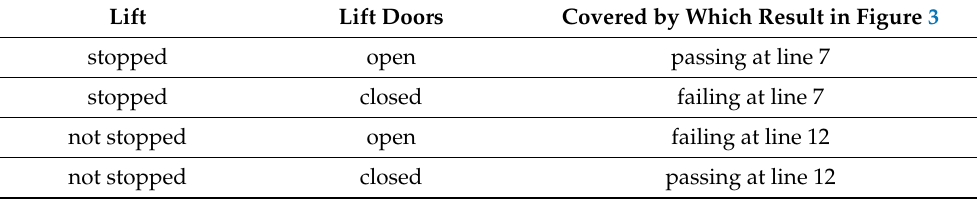
Table 1. All combinations of states of the lift and the doors in checking